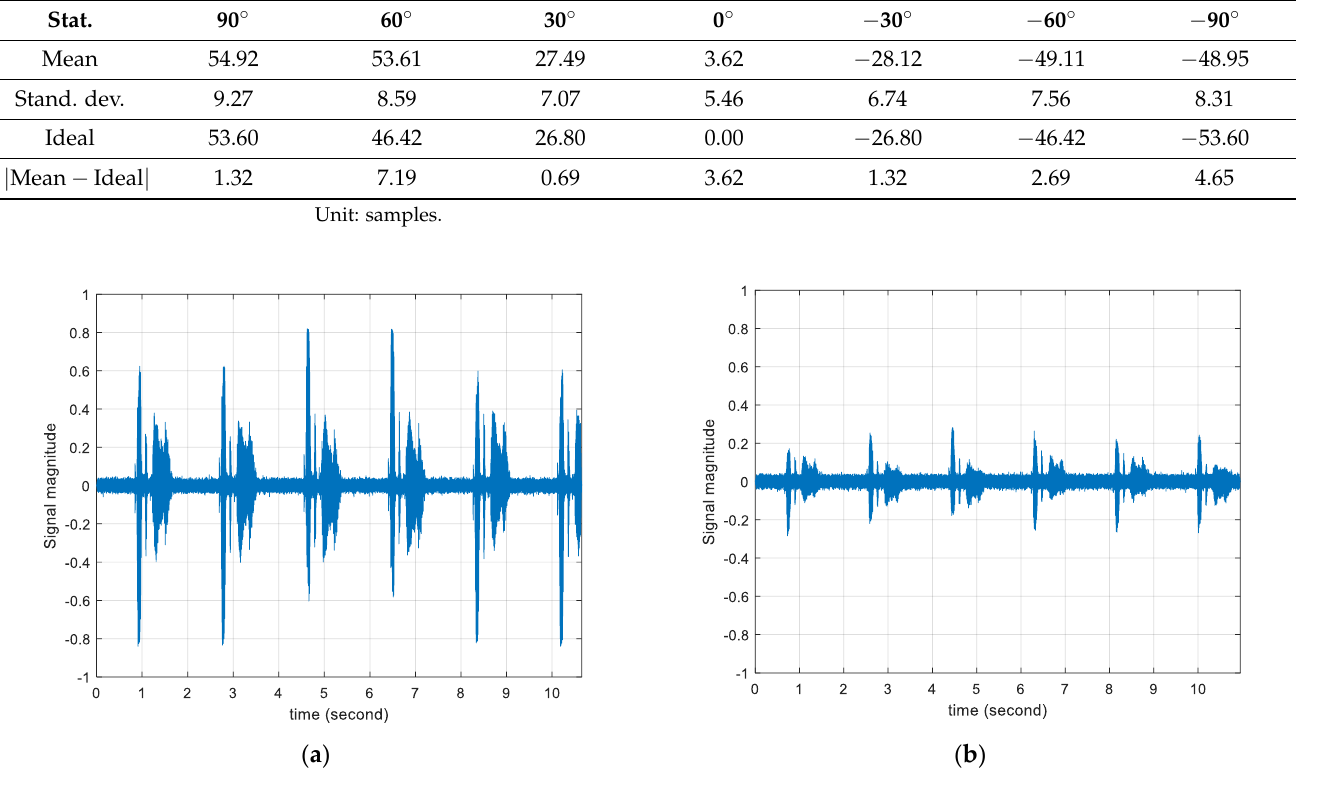
Figure 23. Signal distributions for 1.0 m distance: ( a ) Signal magnitude at 1.0 m with 60 ° ; ( b ) Signal magnitude at 1.0 m with 90 ° .